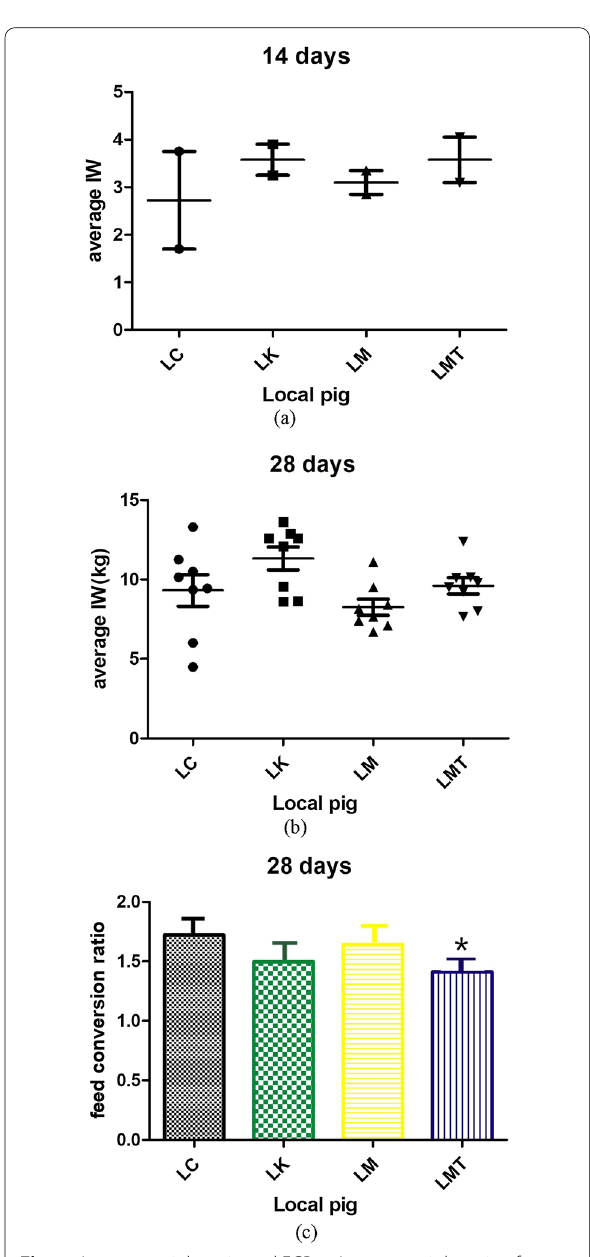
Fig. 1 Average weight gain and FCR. a Average weight gain of weaned piglets at 14 d after the start of the feeding experiment. b Average weight gain at 28 d after the start of the feeding experiment.